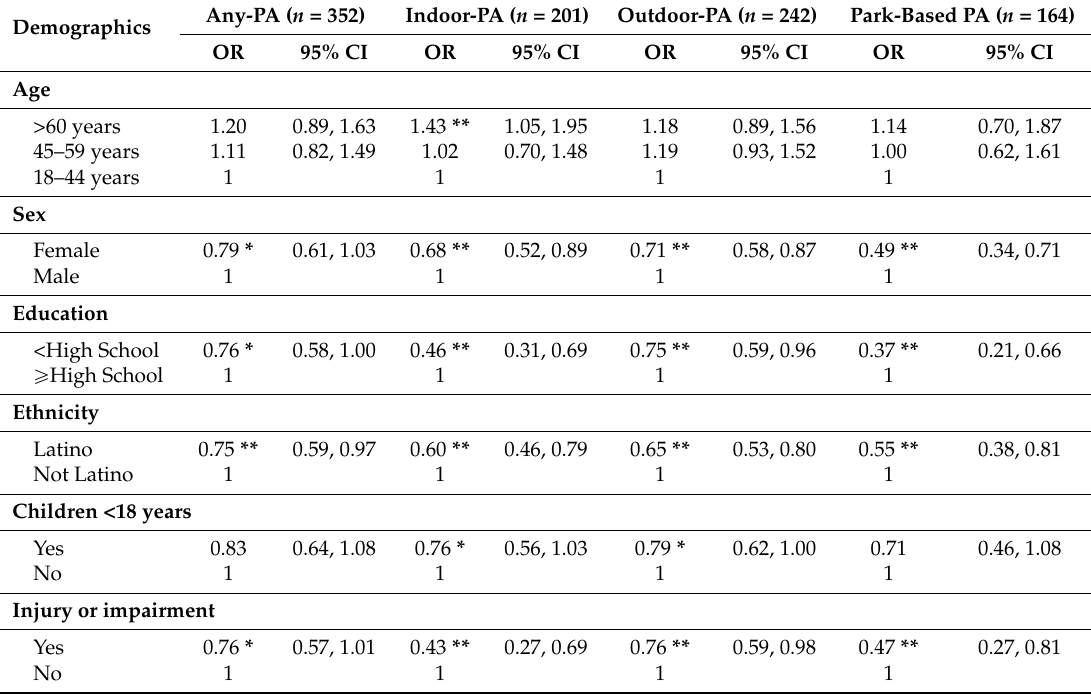
Table 3. Individual odds ratios between demographic variables and physical activity (PA). Any-PA ( n = 352) Indoor-PA ( n = 201) Outdoor-PA ( n = Demographics